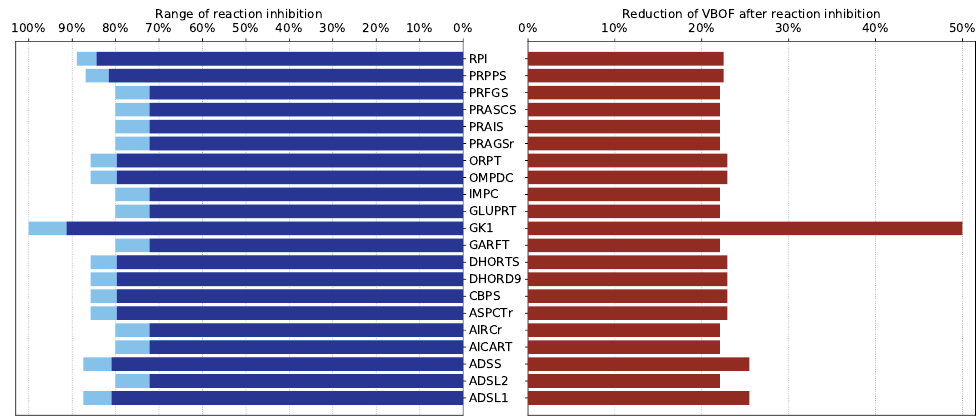
Figure 2. Results of the host-derived enforcement experiments. With the help of the host-derived enforcement, the range and effect of reaction inhibitions on the VBOF can be investigated while keeping the host’s maintenance at 100%. The minimum possible reaction inhibition rate to reduce the viral replication capacity (VBOF) is given in dark blue. The maximum inhibition of the reaction does not harm the host’s maintenance and is indicated in light blue. The reduction of the VBOF is given in comparison to the un-inhibited state. All reaction identifiers are BiGG identifiers [28]. Table A1 lists all reaction identifiers with their corresponding reaction name and the subsystem they occur